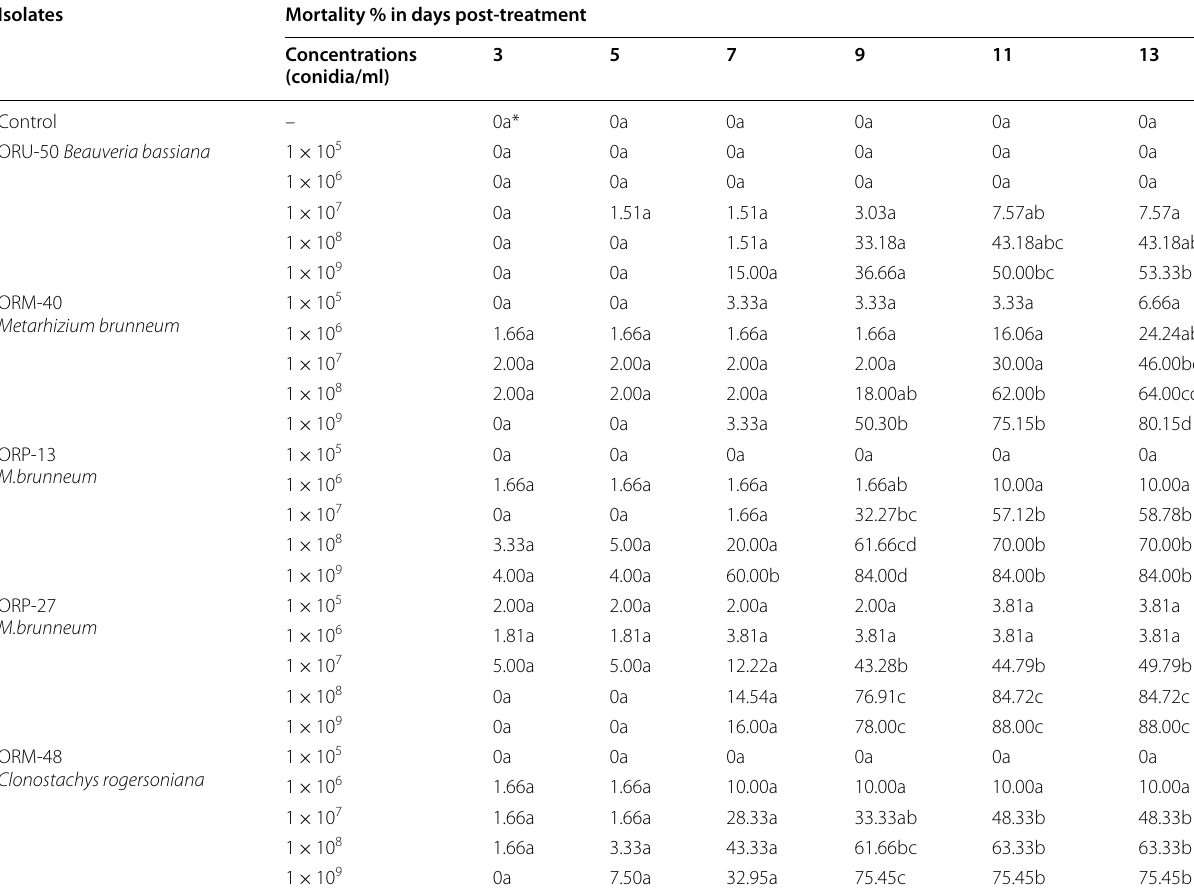
Table 2 Mortality % of Spodoptera littoralis larvae treated with different concentrations of the five isolates displaying the highest mortality rates in single-concentration response tests